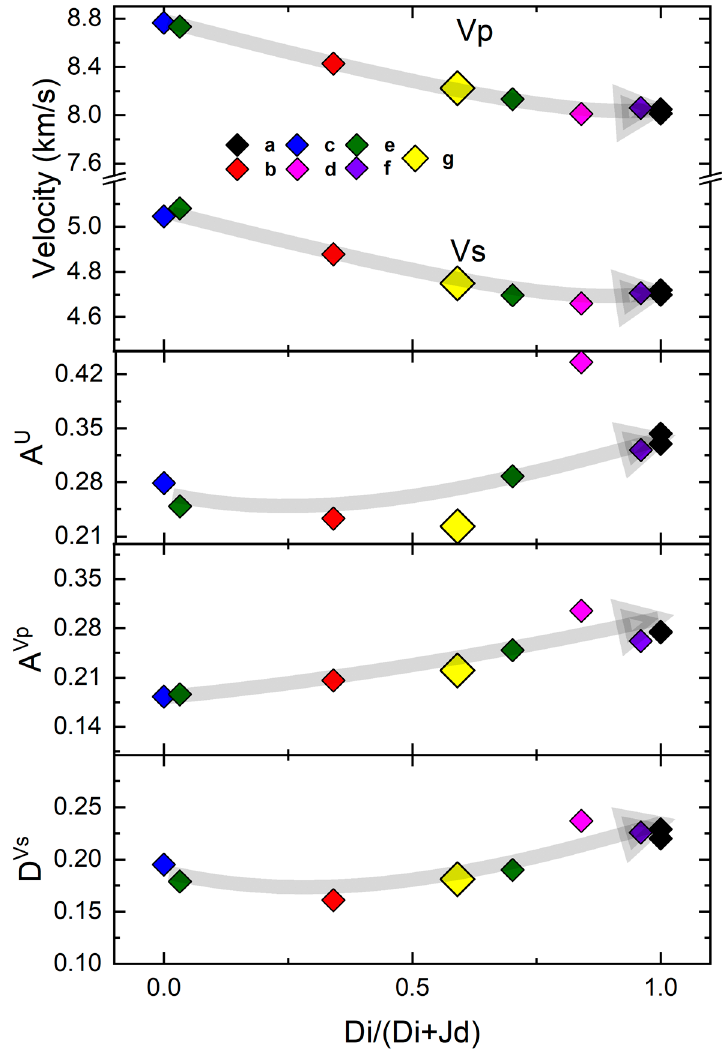
Figure 4. The V p and V s , A U , A Vp , and D Vs of SBB ‐ 46 compared with previous studies on anhydrous